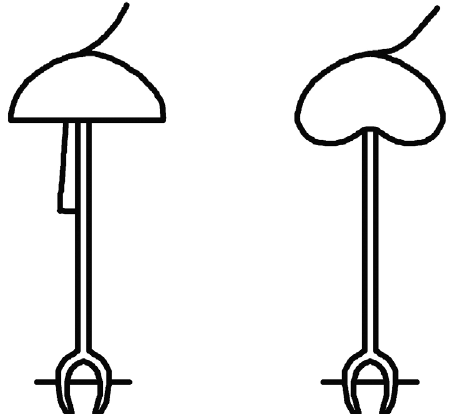
Figure 12. Hieroglyphs derived from the crank drill or borer, Gardiner’s (1957) signs U24 and Journal of Lithic Studies (2016) vol. 3, nr. 3, p. 261-277